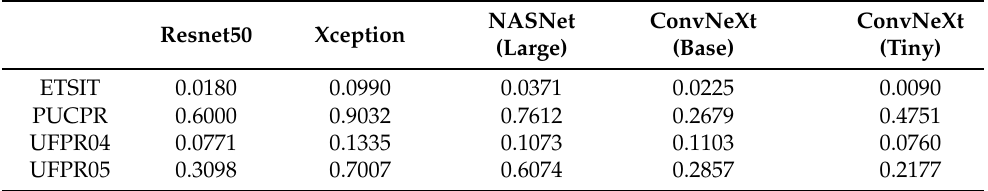
Table 4. Standard deviation of the performance accuracy through all the slots for each backbone.